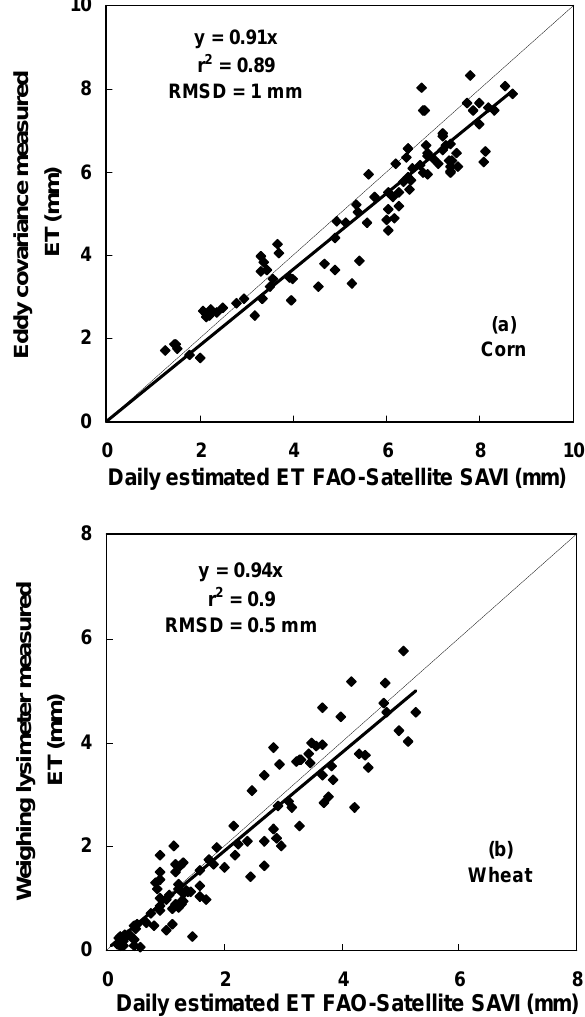
Fig. 5. Daily measured and estimated ET for corn (2009) (a) and wheat (2009) (b) using a satellite-estimated K cb . The thin solid di- agonal line represents the 1:1 line, while the dark line segment rep- Fig.5 Daily measured and estimated ET for corn (2009) (a) and wheat 25 resents the linear regression through the (2009) (b) using a satellite-estimated K cb . The thin solid diagonal line 26 represents the 1:1 line, while the dark line segment represents the linear 27 regression through the points. 28